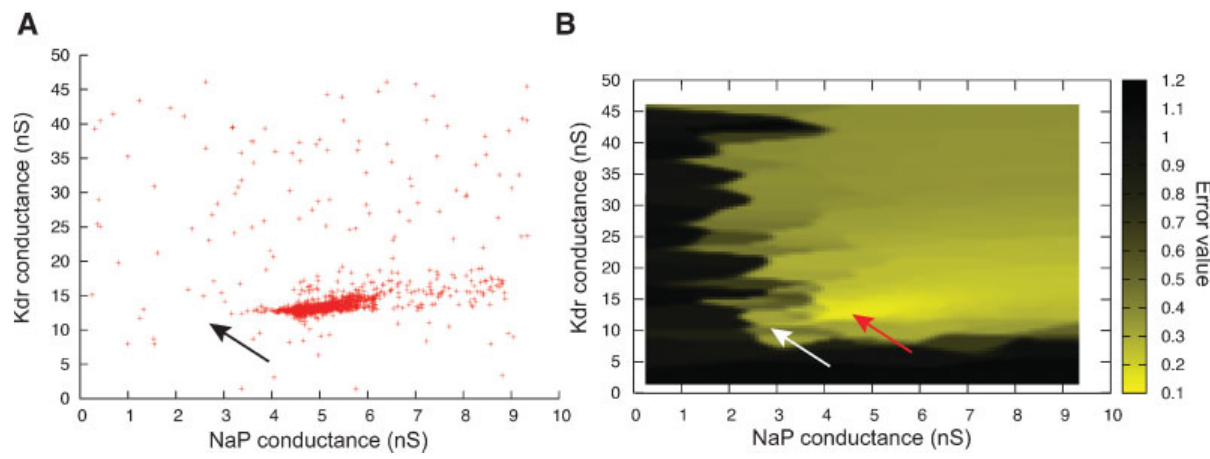
Figure 10. ES search using Equation (1) in the phase-plane trajectory density method . ( A ) Plot of points in the solution space evaluated by Neurofitter during an Evolutionary Strategies search (6000 evaluations) to tune the pacemaker model using Equation (1) for the phase-plane trajectory density method. Every red point represents 1 evaluation. ES is not able to escape a deep region ( B ) Interpolated plot of the error values calculated by Neurofitter during the ES search in ( A ). The global optimal solution with error value 0 is shown by the black and white arrows, but the ES algorithm is not able to escape a local minimum =5nS and g =10–20nS. Remark that plot B does not show a complete representation of the error landscape, but only the shape (red arrow) around g NaP Kdr as seen by ES.